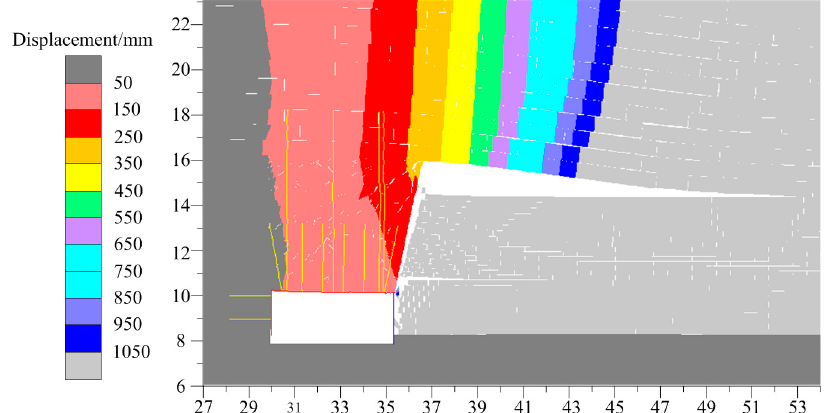
Figure 15. Simulated displacement map of the entry-surrounding rock in a supported condition.